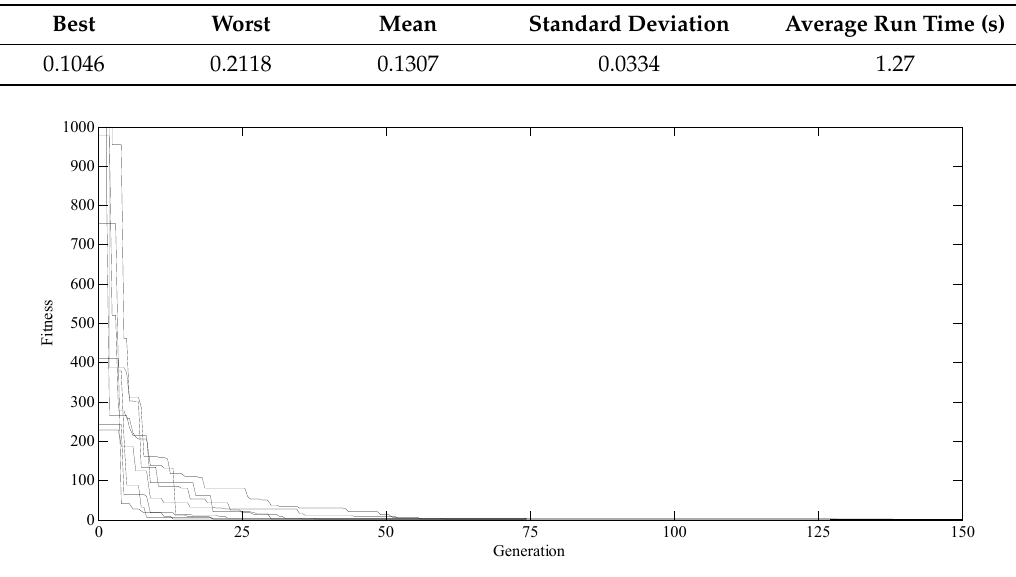
Table 2. Statistics of the optimization results for parameter identification.